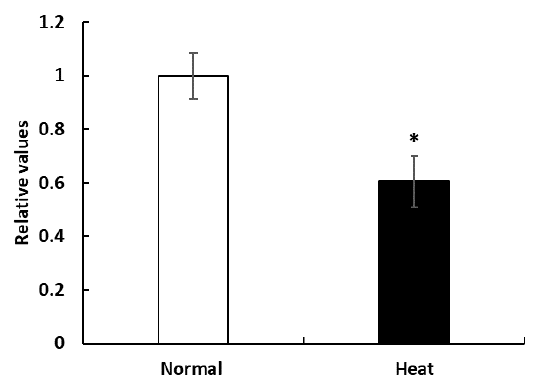
Figure 1. Effects of heat stress on peripheral blood mononuclear cells (PBMCs) proliferation. Cell viability was measured by Cell Counting Kit-8 (CCK-8) assay. Data are presented as the means ± standard errors (n = 5 for each of three experiments). * Means with different superscripts differ significantly ( p < 0.05) between two groups based on Student’s t- test.